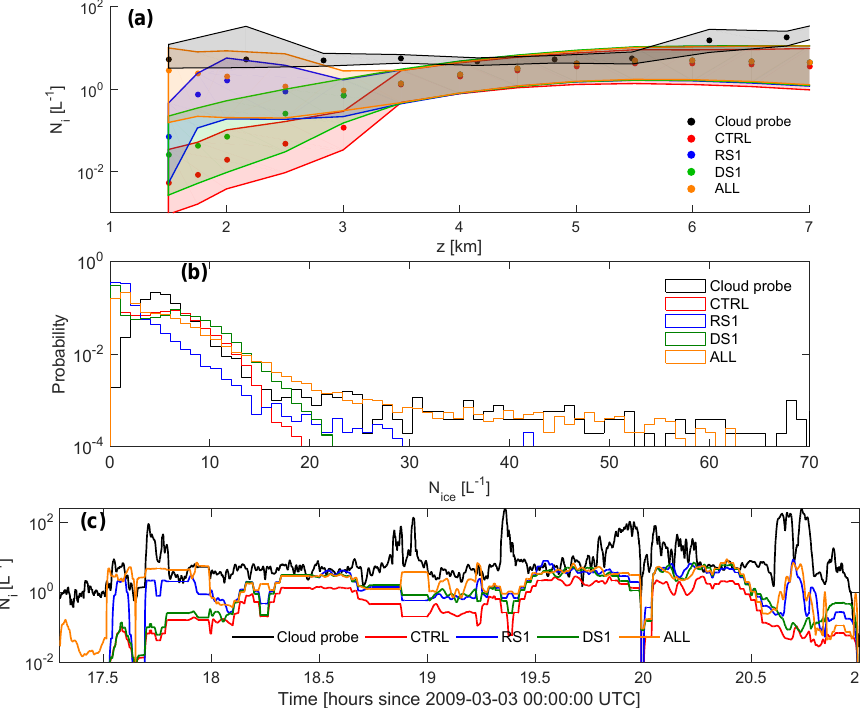
Figure 7. Various distributions of APPRAISE CIP-15 observed and simulated ICNC between 17:00 and 21:00UTC for a small domain centered at CFARR with logarithmic scales. Panel (a) shows altitudinal profiles, where the dotted values indicate median, while the upper and lower envelopes show the first and third quantiles. Panel (b) shows probability distributions and panel (c) shows the 30-point running mean time series. Euclidean distance is minimized to find simulated values that correspond to the observed ones in the time series.